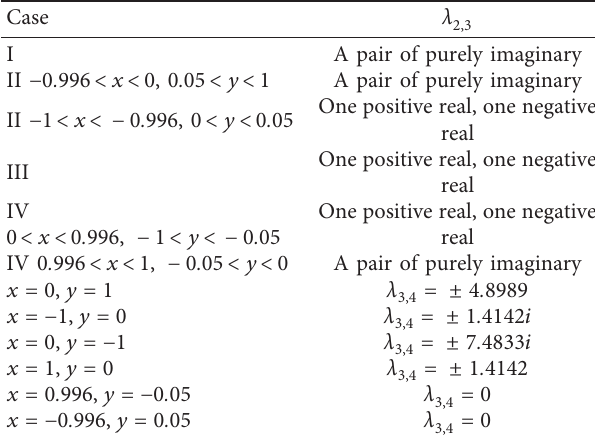
Figure 4: Chaotic system simulation two-dimensional phase diagram. (a) yz phase diagram. (b) xz phase diagram. (c) yw phase diagram. (d) zw phase diagram. Table 2: Eigenvalues of system (2) for k � 2.